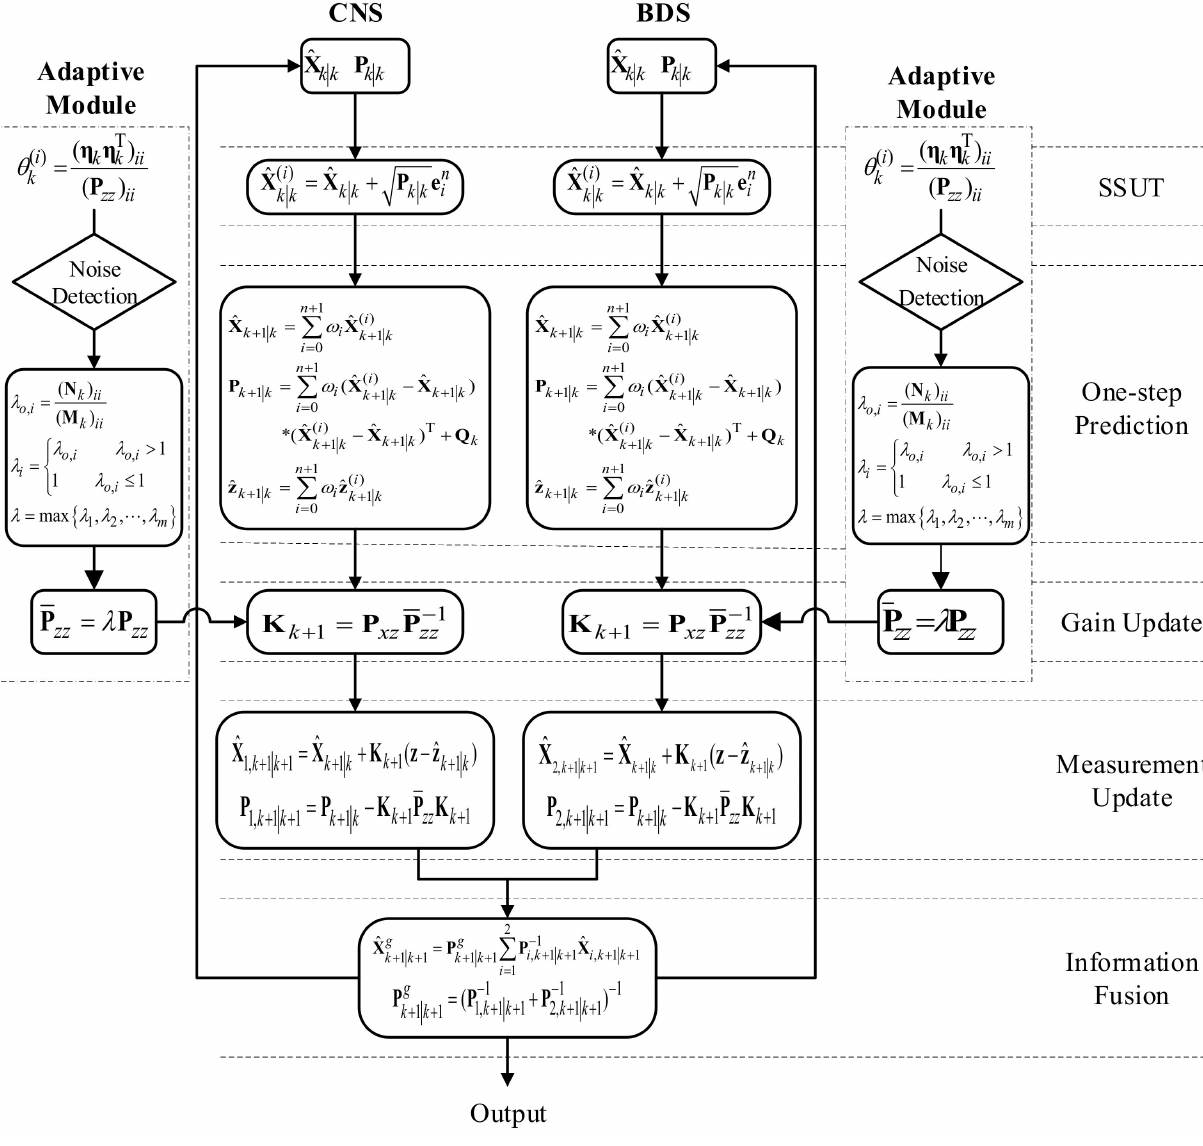
Figure 4. ASSUT-FF algorithm